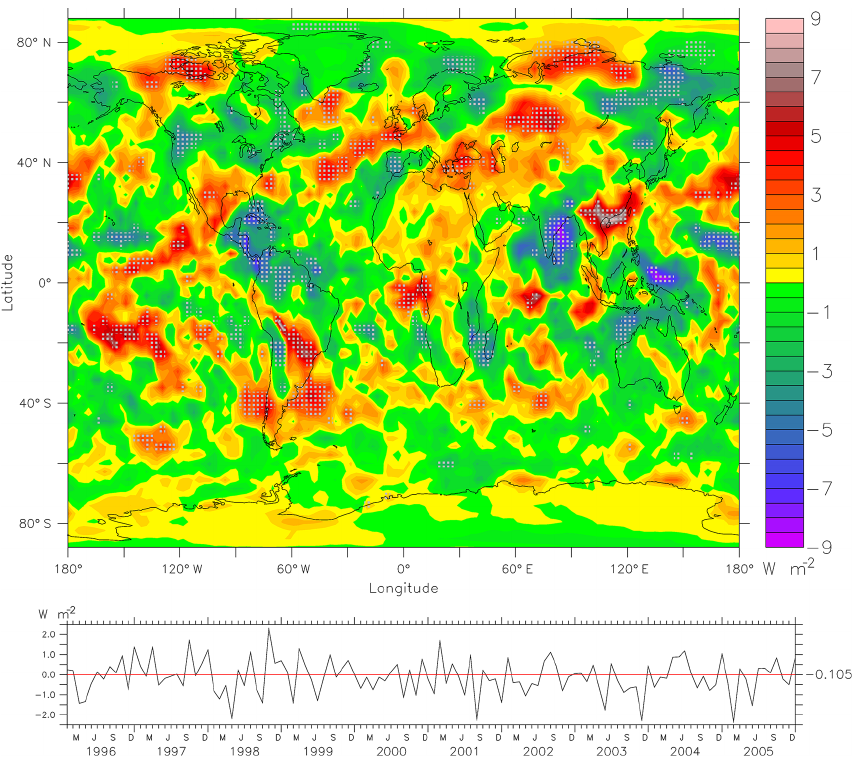
Figure 7. Absolute changes in the shortwave all-sky fluxes at the top of the atmosphere. The upper panel depicts the long-term time average of the difference in the simulation with LNO x emissions minus the fluxes without lightning emissions. The hatches mark regions with a statistically significant signal (compared to the internal interannual variability). The bottom panel depicts the time series of the monthly mean global mean differences with the red line marking a 0Wm − 2